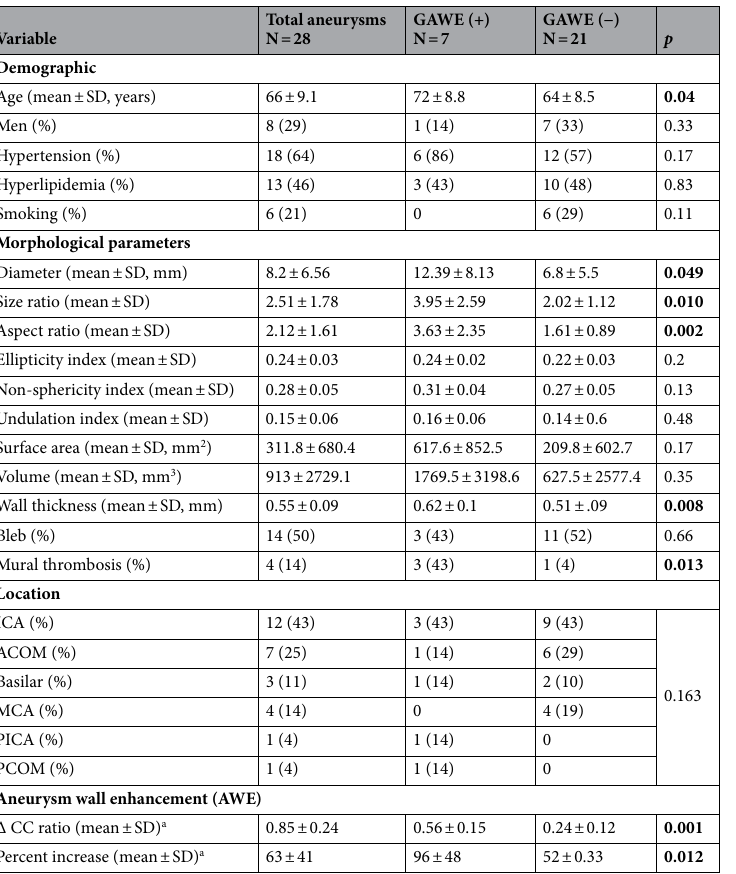
Table 1. Characteristics of saccular aneurysms. a T1 to T1 + Gd. Bold values indicate a significance less than